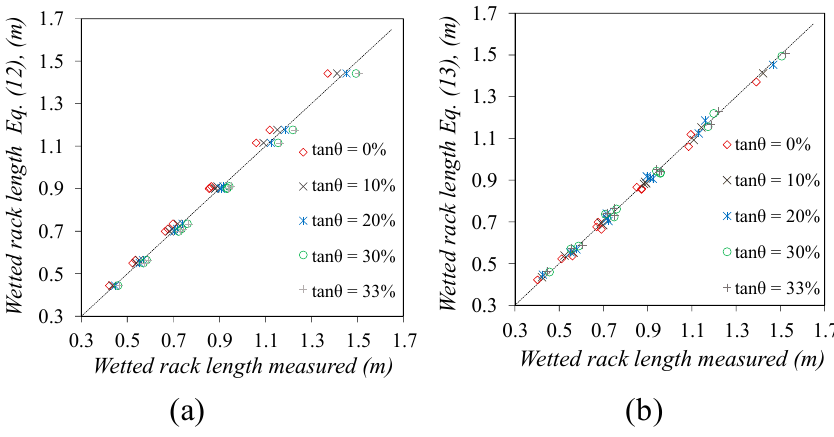
Figure 8. Wetted rack length measured in lab and calculated: ( a ) calculated with Equation (12); ( b ) calculated with Equation (13).